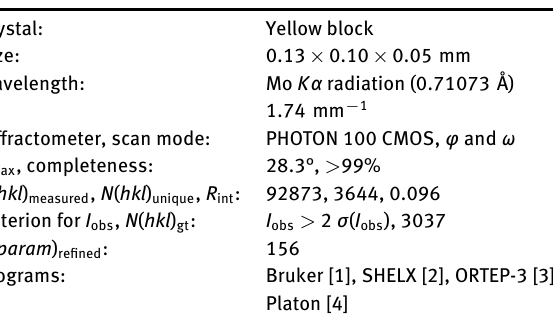
Table 1: Data collection and handling.